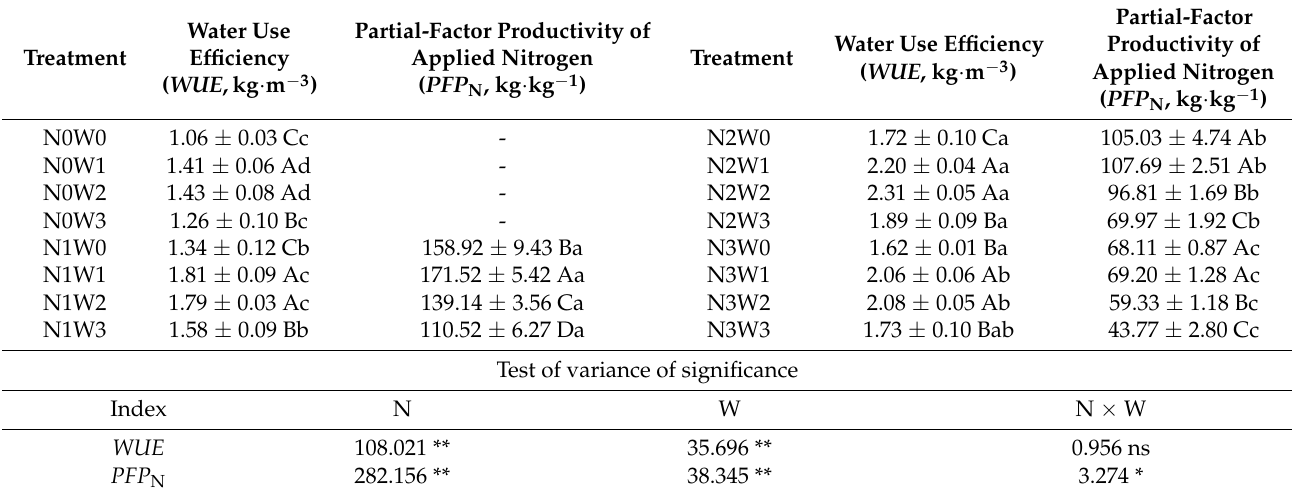
Table 1. Water use efficiency and partial-factor productivity of applied nitrogen of Bromus inermis under water-nitrogen